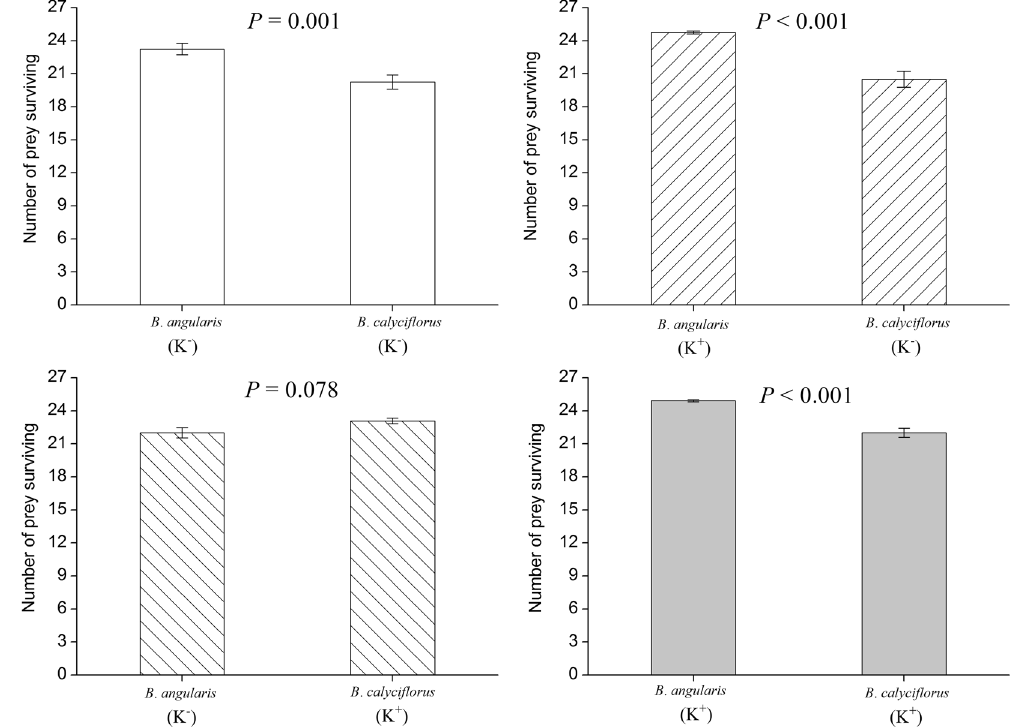
Figure 4. Survival of Brachionus calyciflorus ( B . c .) and Brachionus angularis ( B . a .) cultured together with Asplanchna brightwellii . At each prey combination, B . c . and B . a . cultured in the medium with (K + ) and without (K − ) Asplanchna kairomones are provided with proportion of 50%: 50% (25 individuals from each species). We conducted the experiments with newborn B . c . and non-ovigerous adult B . a . (see the legend in Fig. 3 for the detailed explanation). Data are mean ± S.E. based on 12 replicated observations.